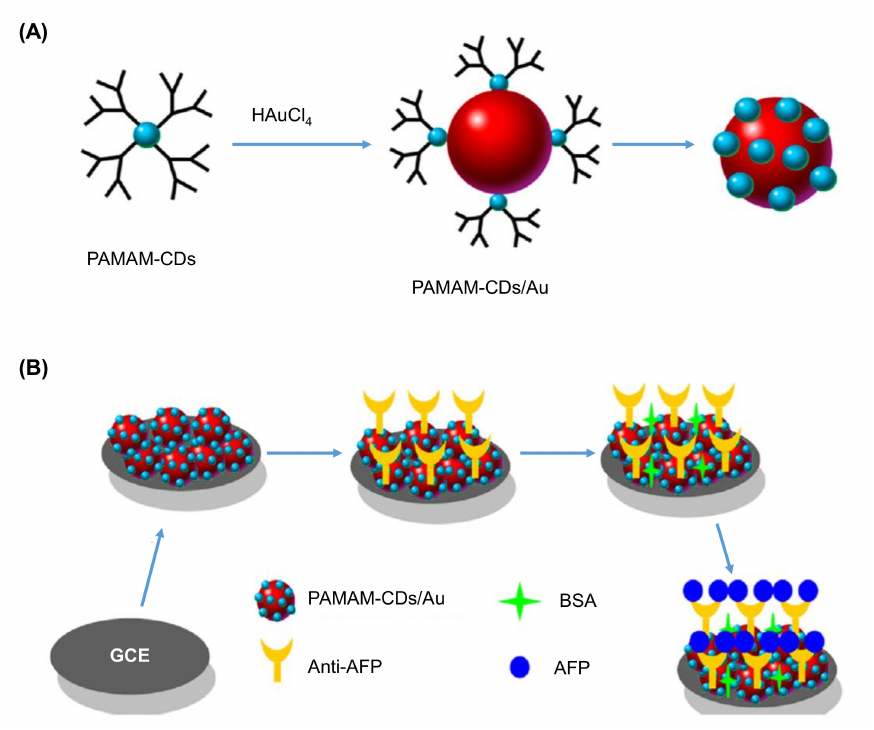
Figure 13. ( A ) Formation of PAMAM-CDs/Au hybrid nanomaterial. ( B ) Modification of GCE surface for the development of voltammetric immunosensor to detect AFP. Reproduced from [226], with permission from Elsevier,